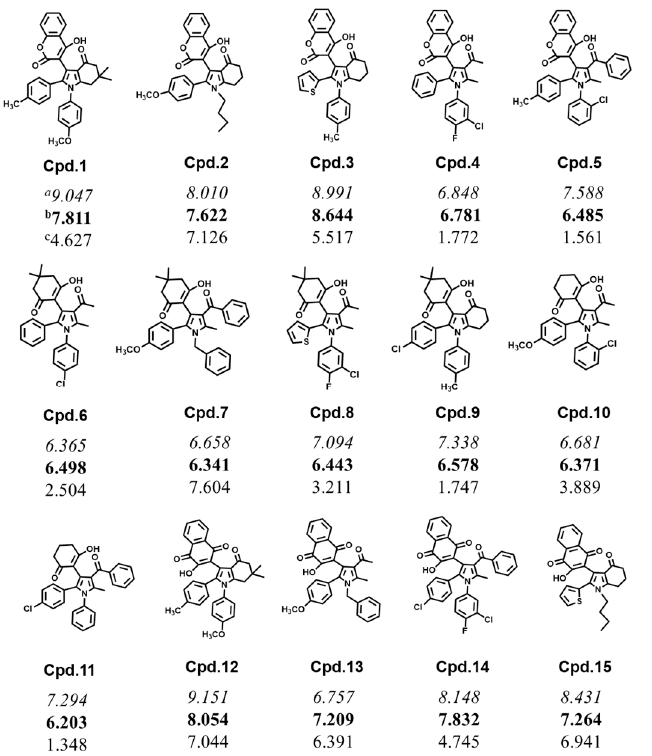
Figure 6. Pyrrole derivatives and their radical scavenging activities. The data are expressed as the (percent scavenging activity)/10 toward a • OH at a compound concentration of 80 µ M (in italics), b O 2• − at 20 μ M (in bold), and c DPPH • at 90 μ M (in normal font) [30]. 2 Data sets. The data of pyrrole derivatives were divided into a training set (80%) and